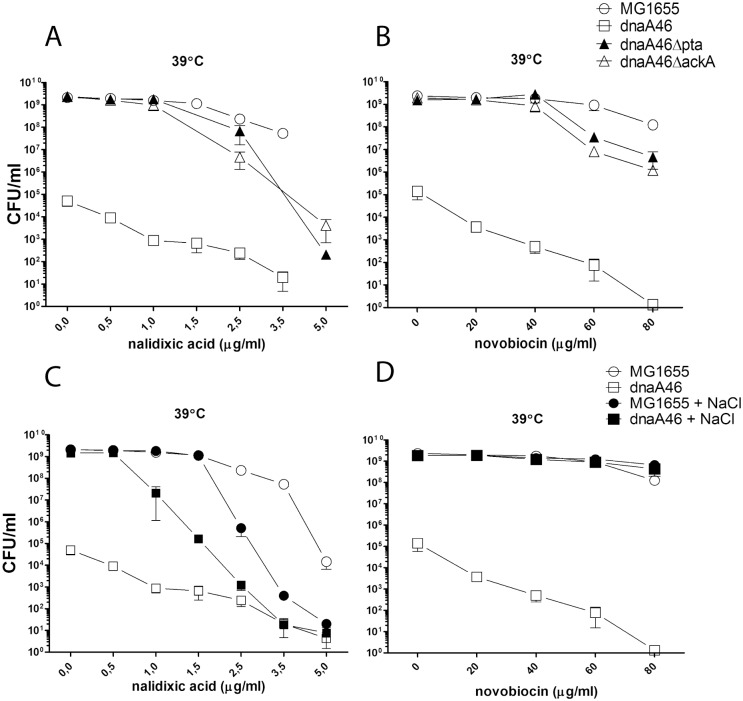
Sensitivity to gyrase inhibitors of the dnaA46 strain lacking a part of acetate overflow pathway (AB) or growing in the presence of 0.5 M NaCl (CD).Indicated concentrations of nalidixic acid (AC) or novobiocin (BD) were used. Bacteria were grown on LB plates at 30 and 39°C and growth was estimated by CFU. Data represents mean ± SEM of three independent experiments.